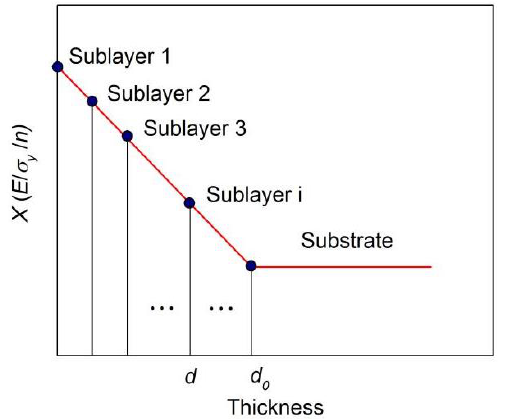
Figure 3. A linear model of the elastic modulus, yield stress and strain hardening exponent for the Mo modified